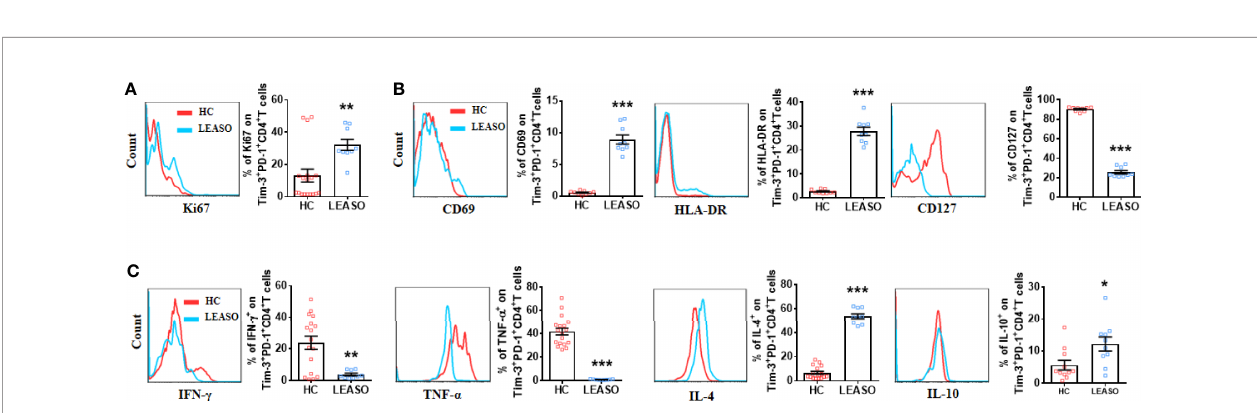
FIGURE 2 | CD4 + T cells co-expressing Tim-3 and PD-1 from LEASO patients displayed a distinctive phenotype compared to Tim-3 - PD-1 - CD4 + T cells in vitro . (A) ABMCs from the LEASO (n = 9) were stained with antibodies against CD4, CD69, HLA-DR, CD127, and CD45RO and then analyzed by fl ow cytometry. (B) Quanti fi cation of Ki67 staining in Tim-3 + PD-1 + CD4 + T cells and Tim-3 - PD-1 - CD4 + T cells from LEASO, n = 9. (C) Cytokine production by Tim-3 + PD-1 + CD4 + T cells and Tim-3 - PD-1 - CD4 + T cells from LEASO, n = 9. Data represent mean ± SEM. *P < 0.05, ** P < 0.01, *** P <